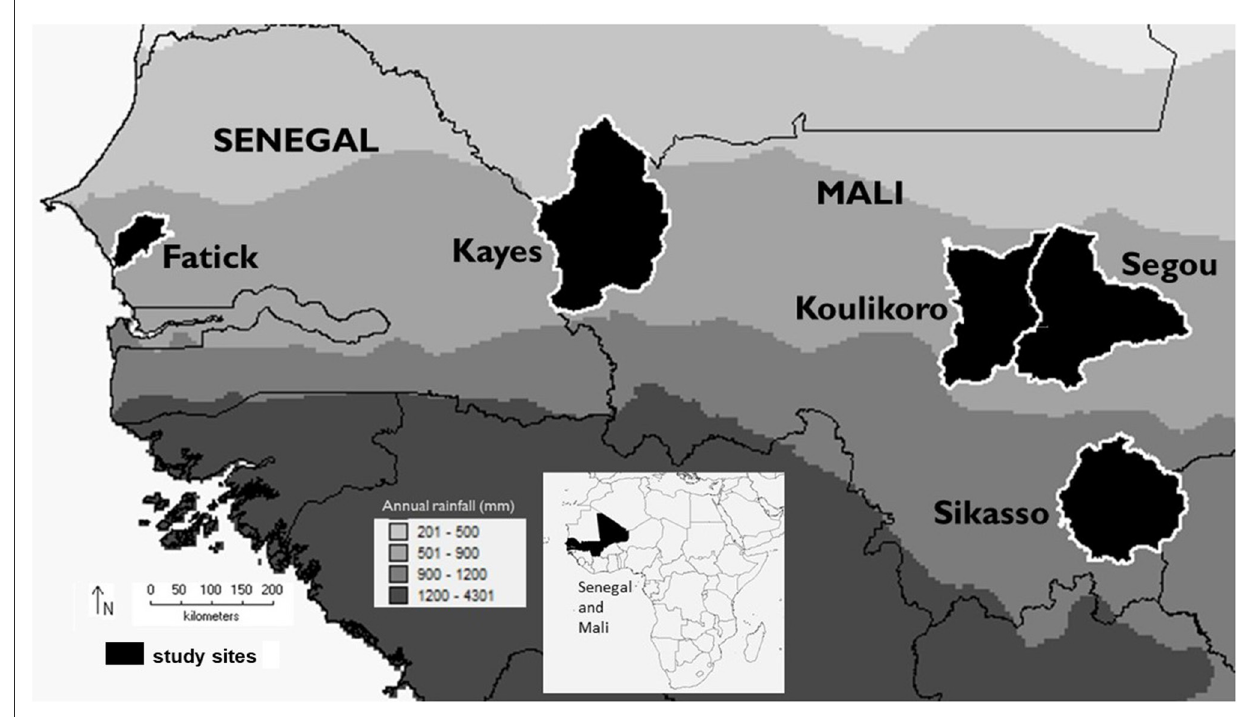
FIGURE1 Map of the study area with 5 sites (source: all map layers were available in DIVA-GIS: www.diva-gis.org).